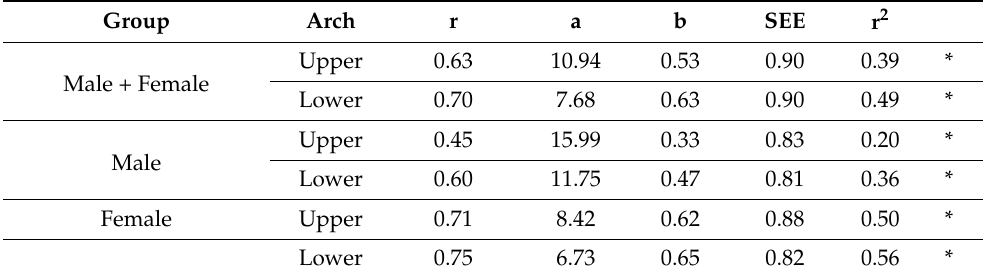
Figure 3. ( a ) Regression of actual tooth sizes of the upper canines and premolars and the sum of mandibular incisors for males; ( b ) regression of actual tooth sizes of lower canines and premolars and the sum of mandibular incisors for males; ( c ) regression of actual tooth sizes of upper canines and premolars and the sum of mandibular incisors for females; ( d ) regression of actual tooth sizes of lower canines and premolars and the sum of mandibular incisors for females. Table 4. Regression parameters for predictions of the combined mesiodistal width of canines and premolars and the sum of widths of mandibular incisors.